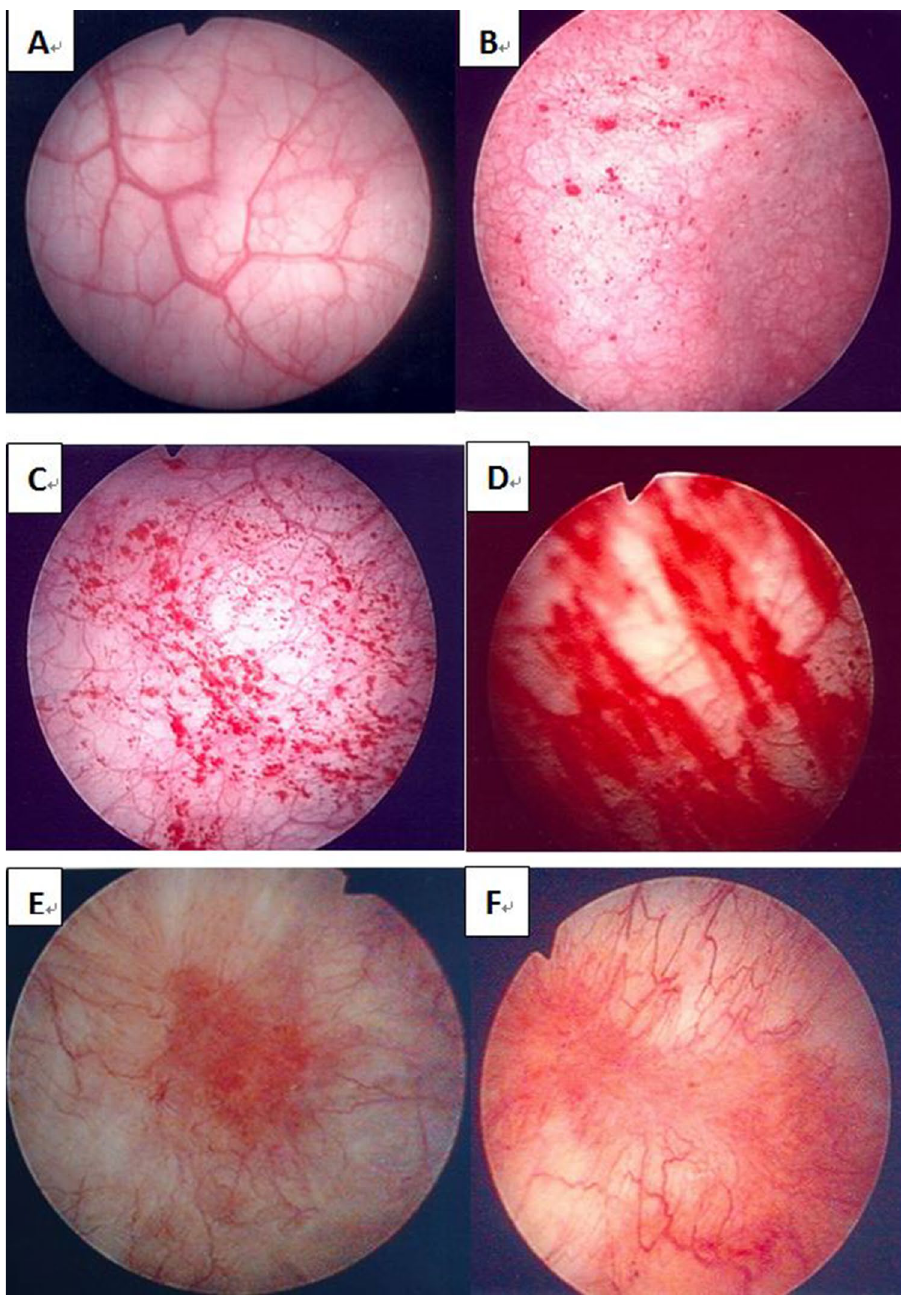
Figure 2. The pictures of cystoscopic hydrodistention of interstitial cystitis after hydrodistention: ( A ) grade 0, ( B ) grade 1, ( C ) grade 2, ( D ) grade 3, ( E , F ) Hunner’s